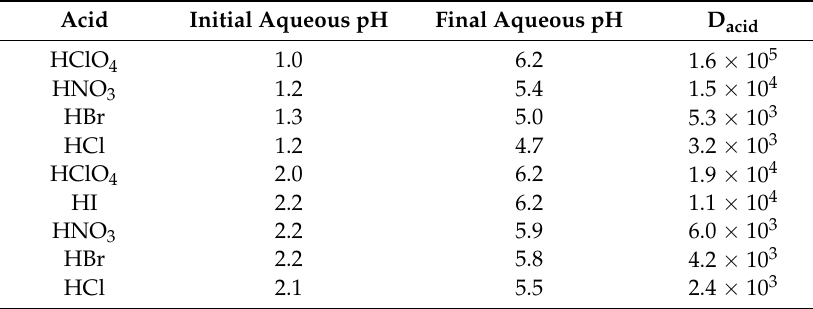
Table 2. Distribution coefficients as a function of initial pH and identity of the acid.